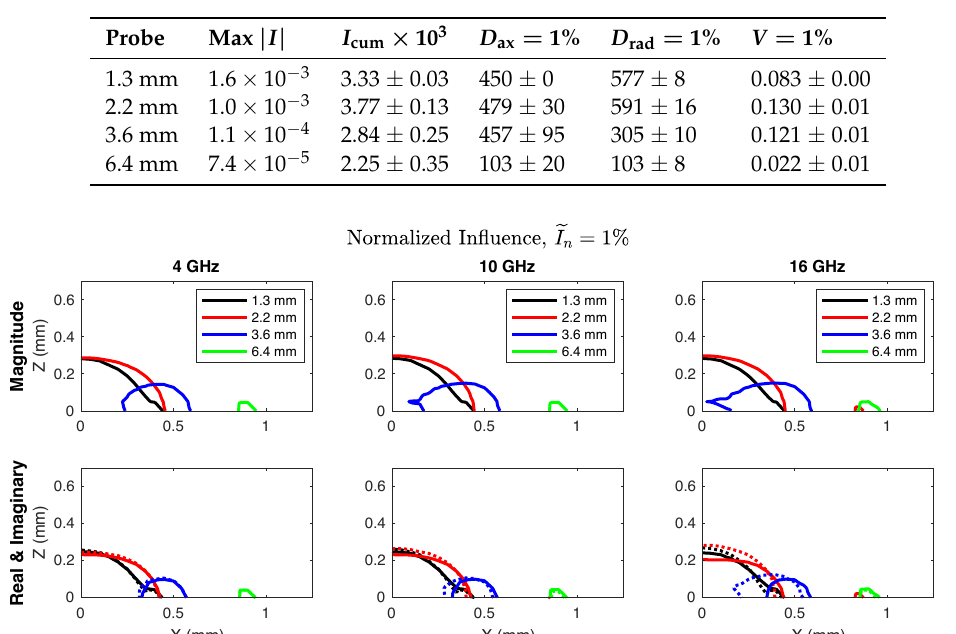
Figure 4. Normalized influence in the xz -plane, where x = 0 coincides with the probe symmetry axis and z = 0 lies along the probe measurement plane. The top row shows influence magnitude, while the bottom row shows influence in the real (solid lines) and imaginary (dotted lines) parts. The measurement volume defined by the 1% contour was inversely related to probe size and centered around the outer radius of the coaxial center conductor. There was some spatial separation in the influence on real and imaginary parts at frequencies above